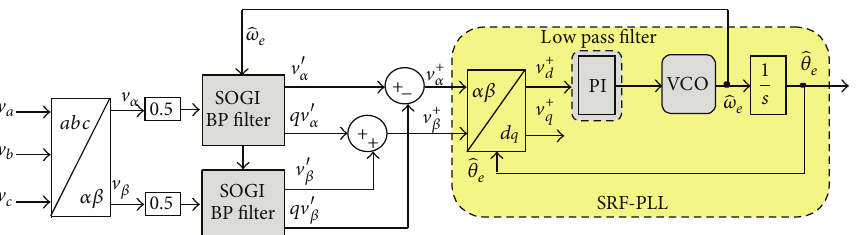
Figure 2: Schematic diagram of